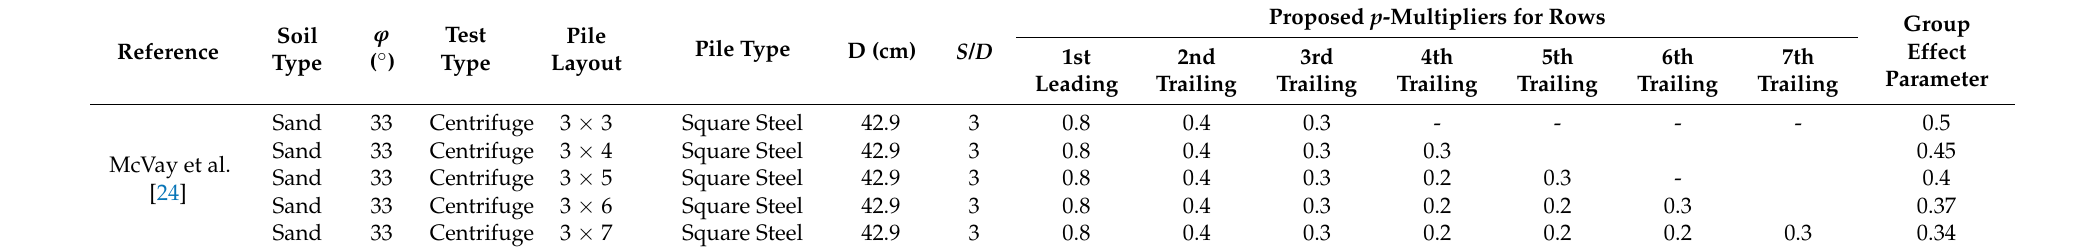
Table 2. Previous experimental studies conducted on fixed-head pile groups (modified after Fayyazi [14]).